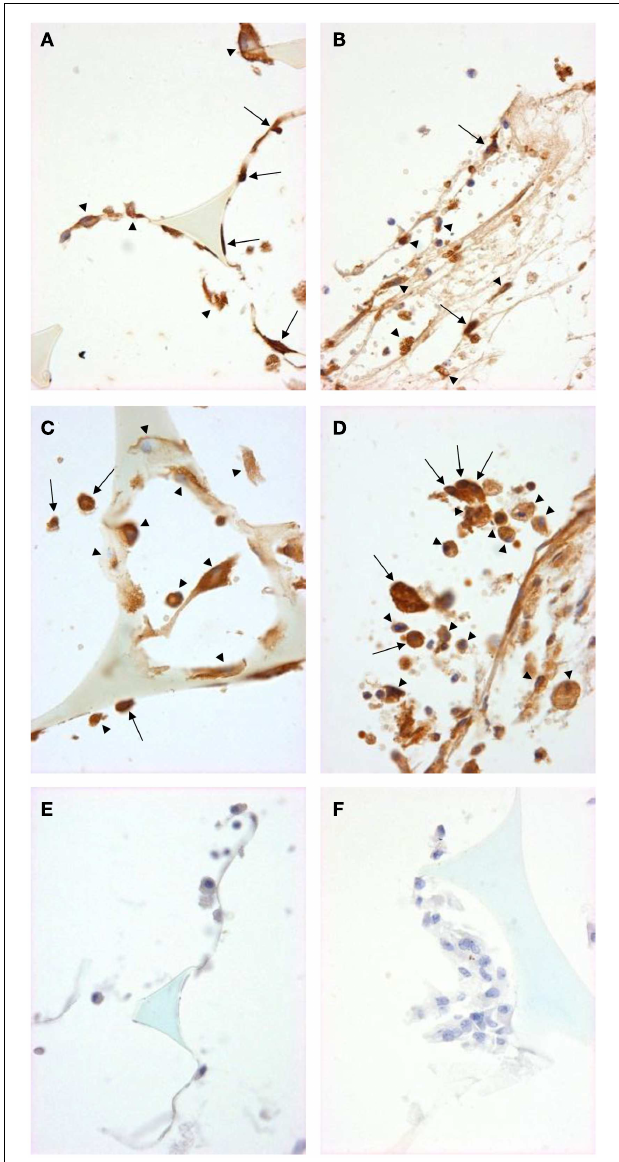
FIGURE 3 | M1 marker staining of sponge sections fromApoE KO or ApoE/Rag-1 DKO mice . Sections from ApoE KO (A,C,E) or DKO mice (B,D,F) were stained to show immunolocalization of inducible nitric oxide synthase (iNOS) (A,B) or cyclooxygenase-2 (COX-2) (C,D) . Control sections (E,F) were exposed to non-immune IgG. Positive staining appears brown (DAB), nuclei blue-purple (hematoxylin), and sponge spicules light blue. Sections from either mouse strain could contain cells with positive cytoplasmic staining (arrowheads). Some cells did not stain, and some appeared to have COX-2 in their nucleus (arrows) (Magnification: × 600).